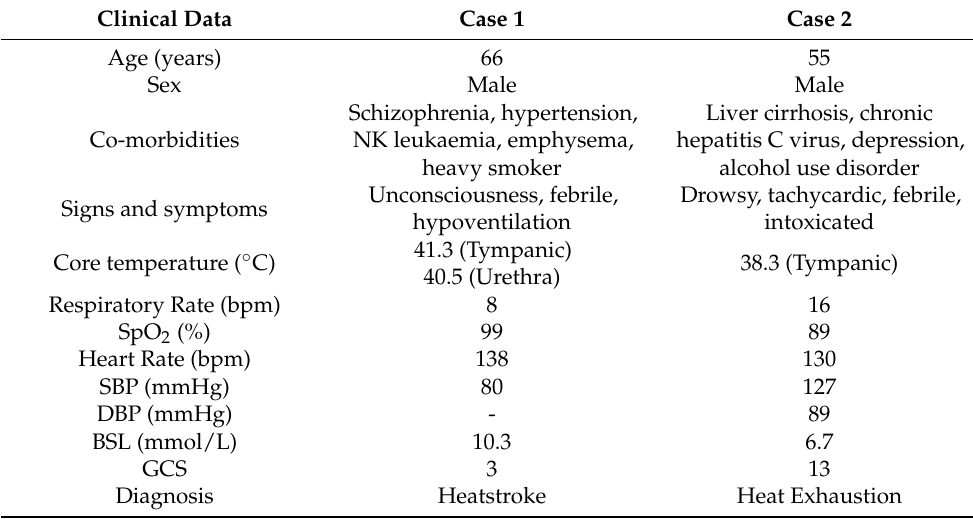
Table 1. Main clinical data at time of